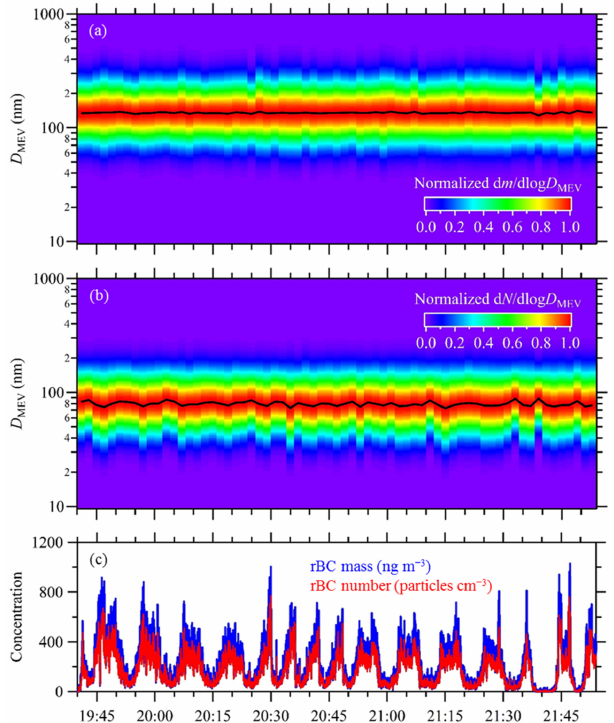
Figure 4. Time-resolved rBC (a) mass size distribution, (b) number size distribution and (c) concentrations observed over the CNRL facility during F_8/26. Solid lines in (a) and (c) indicate MMD and NMD, respectively. The horizontal axis shows UTC